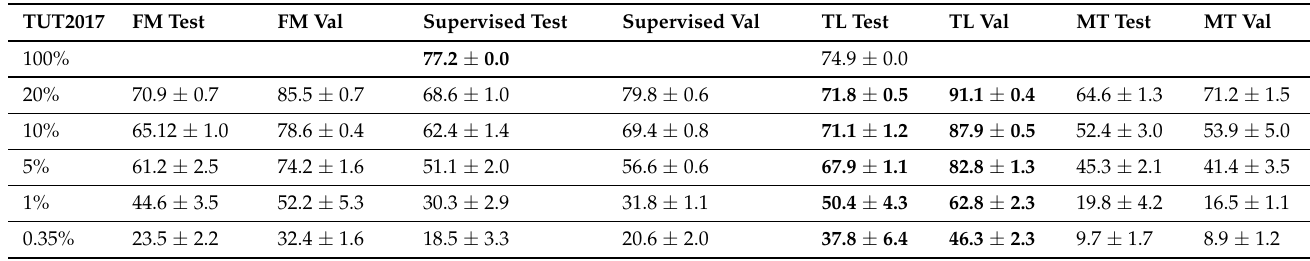
Table A2. Detailed results for TUT2017 dataset from Figure 5 with file-wise accuracy and standard deviation on test set (test) and unlabeled training set (val).